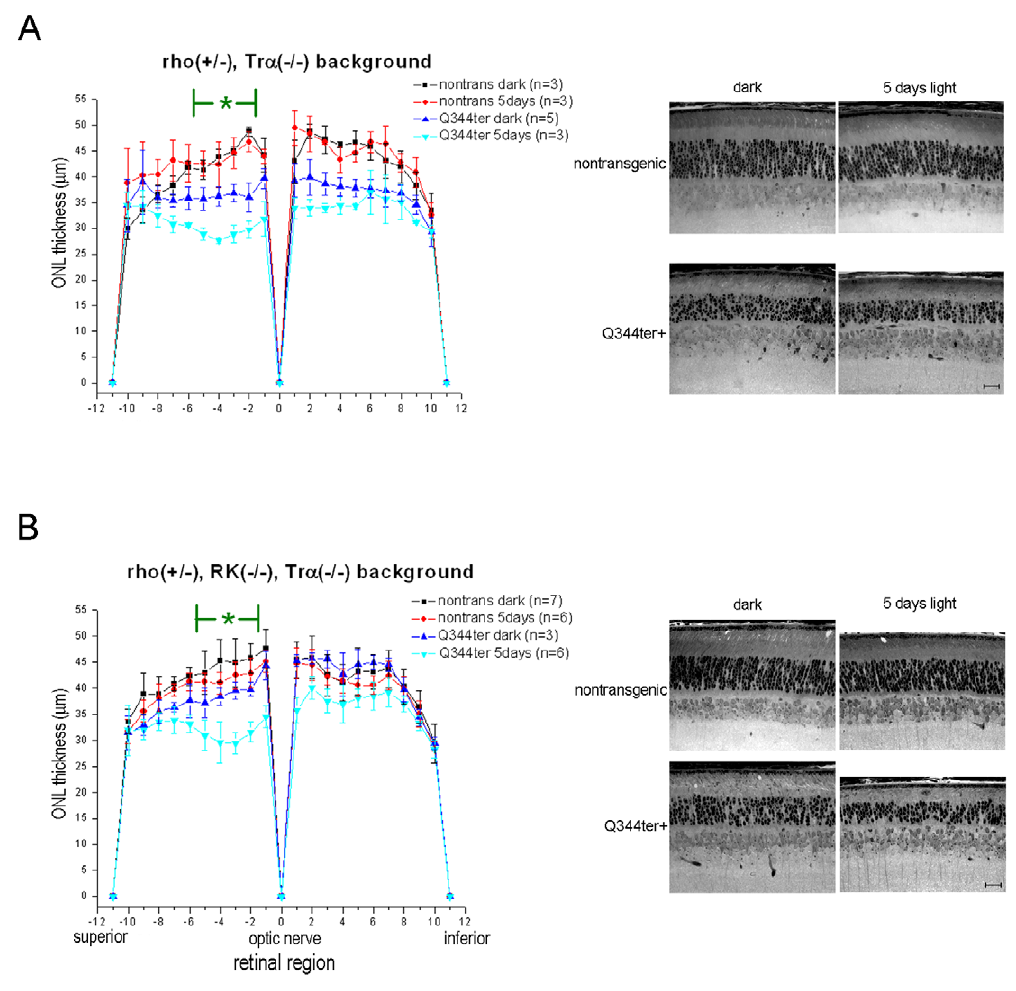
Figure 6. Light-exacerbated retinal degeneration in Q344ter mice is ameliorated in the Tr a 2 / 2 background. Dark-reared mice were kept in darkness or exposed to light for 5 days as in Fig. 5 ( A ) Retinal morphometry of Q344ter rho + / 2 in the Tr a 2 / 2 background. In the dark-reared group expression of the Q344ter transgene consistently caused a moderate thinning of the ONL. Light-exposure had no noticeable effect on the transgene negative mice, but caused further thinning of the ONL in Q344ter rho + / 2 mice. However, this effect was less severe when compared to the Tr a + / + background (Fig. 5A). ( B ) The Q344ter rho + / 2 , Tr a 2 / 2 mice were further crossed into the RK 2 / 2 background to prevent light-induced formation of stable rhodopsin/Arr1 complexes. No additional rescuing effect beyond that seen in the Tr a 2 / 2 background was observed in the light- exposed transgenic Q344ter mice in the RK 2 / 2 , Tr a 2 / 2 background. Representative light micrographs of retinal sections are shown on the right. Scale bars =20 m